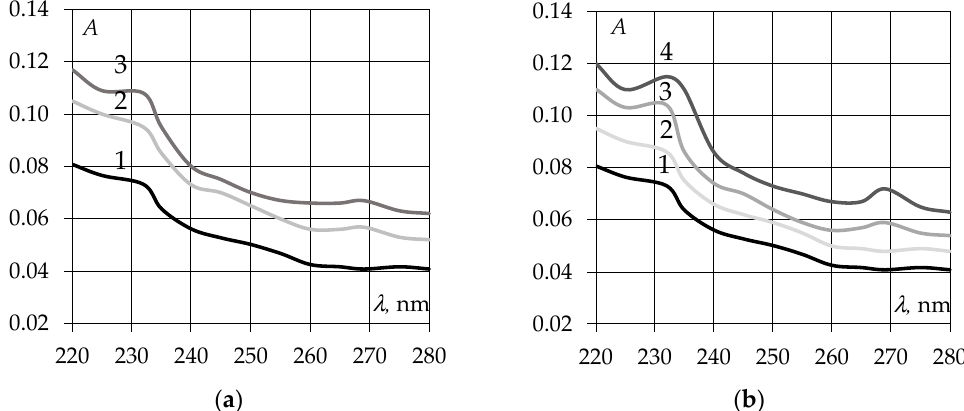
Figure 4. Changes in UV absorption spectra of 0.02% solutions in isooctane during storage of EAGO at a temperature of ( a ) 50 ± 1 ◦ C for: 1—0 days; 2—40 days and 3—60 days; ( b ) 100 ± 1 ◦ C for: 1—0; 2—72 × 60 2 s; 3—124 × 60 2 s; 4—144 × 60 2 s.